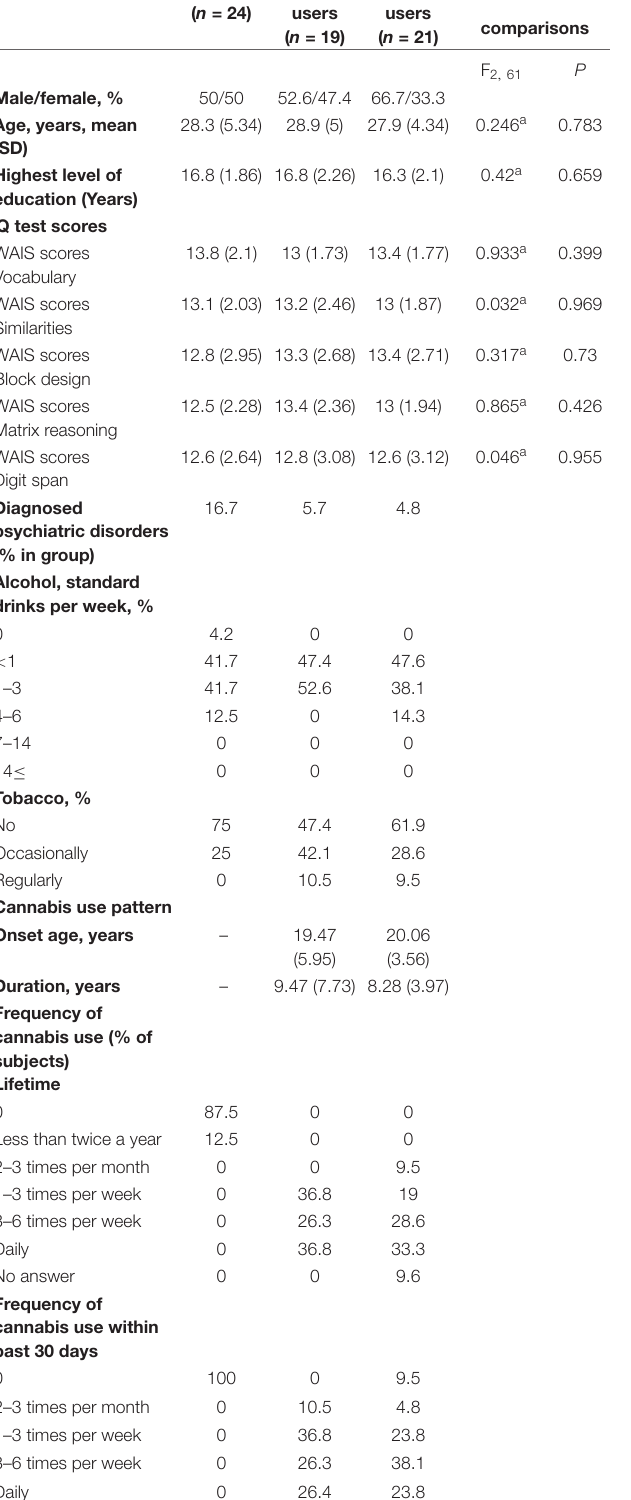
TABLE 2 | Demographic, neuropsychological and substance use characteristics for participants included in event-related potential (ERPs) analyses. Group ( n =